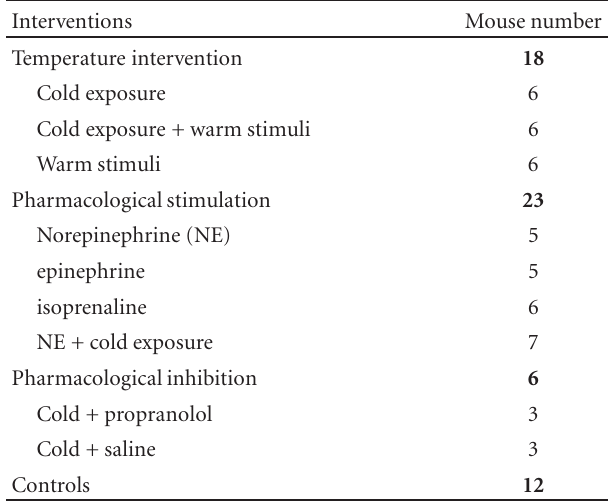
Table 1: Groups according to interventionsand the number of mice in each